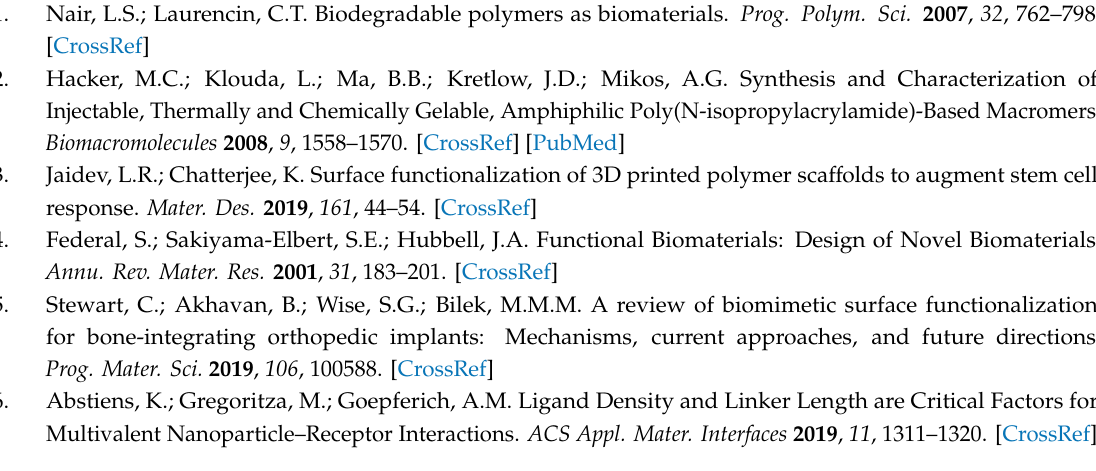
Figure S1: Illustration of the material